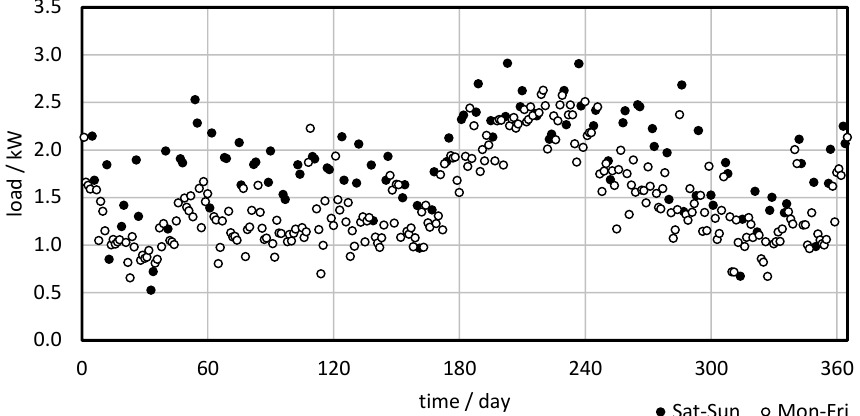
Figure 6. Seasonal variation in the normalized maximum daily loads.